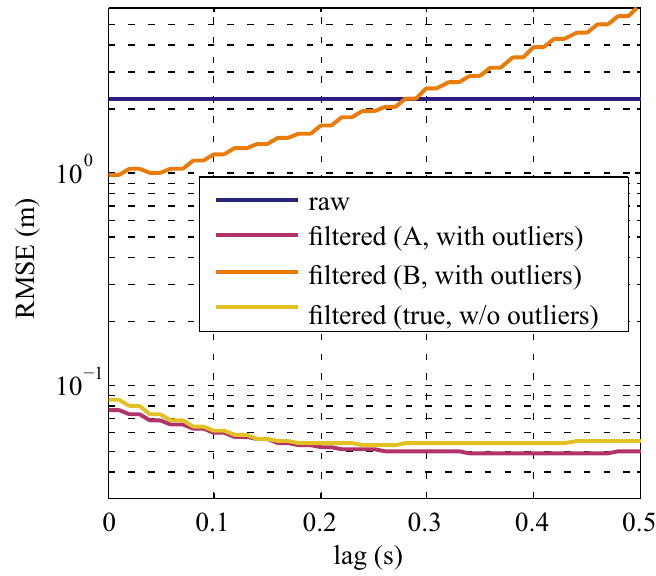
Figure 4. RMSE of Dataset D 1 (without training set). The blue line shows the RMSE of the unfiltered data (including outliers). The RMSE obtained by filtering the data (including outliers) with the parameters from the proposed method ( A ) is depicted in purple. The orange curve corresponds to the filtering results obtained using the parameter estimation from [34], without special handling of the outliers in the data ( B ). The yellow line represents the results for filtering the data without outliers and with the true simulated noise parameters. The ripple in the filtered curves corresponds to the smallest sampling interval of 10 ms.